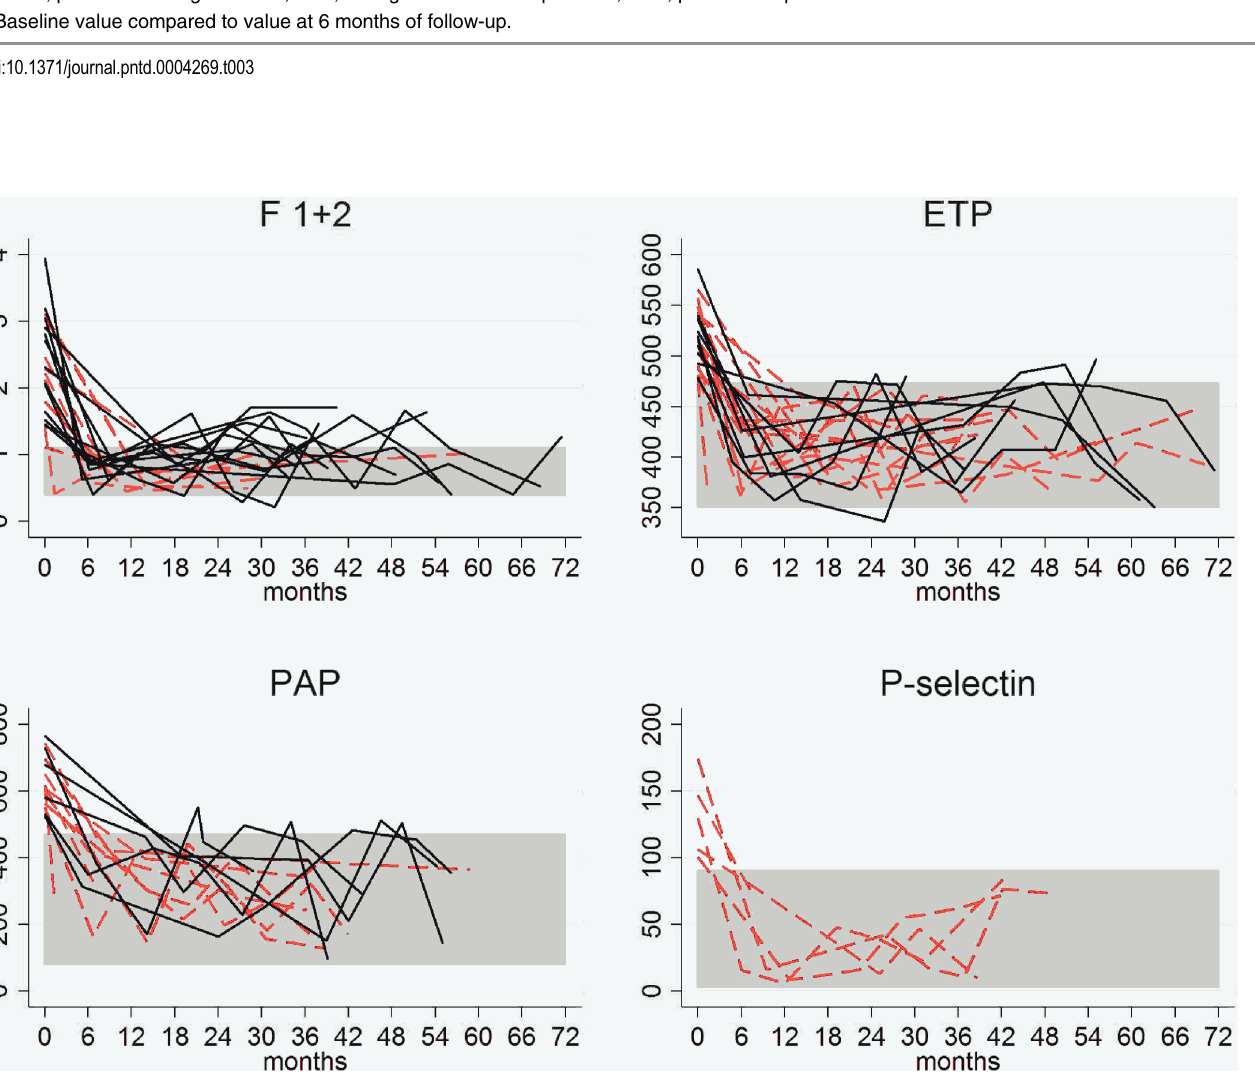
b F 1+2, prothrombin fragment 1+2; ETP, endogenous thrombin potential; PAP, plasmin-antiplasmin c Baseline value compared to value at 6 months of follow-up.